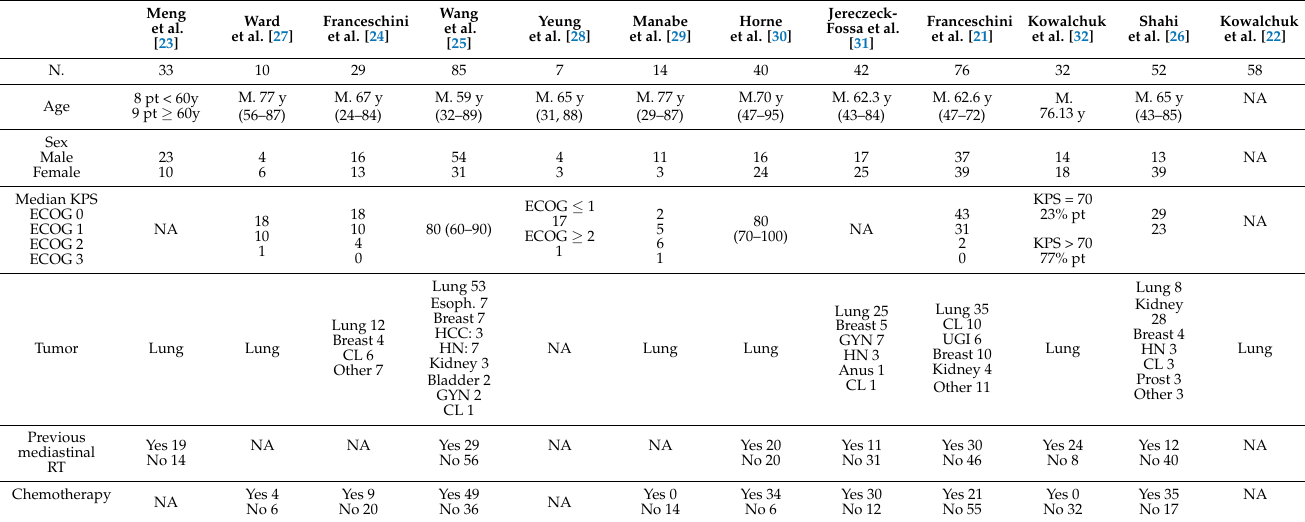
Table 1. Summary of patient characteristics.